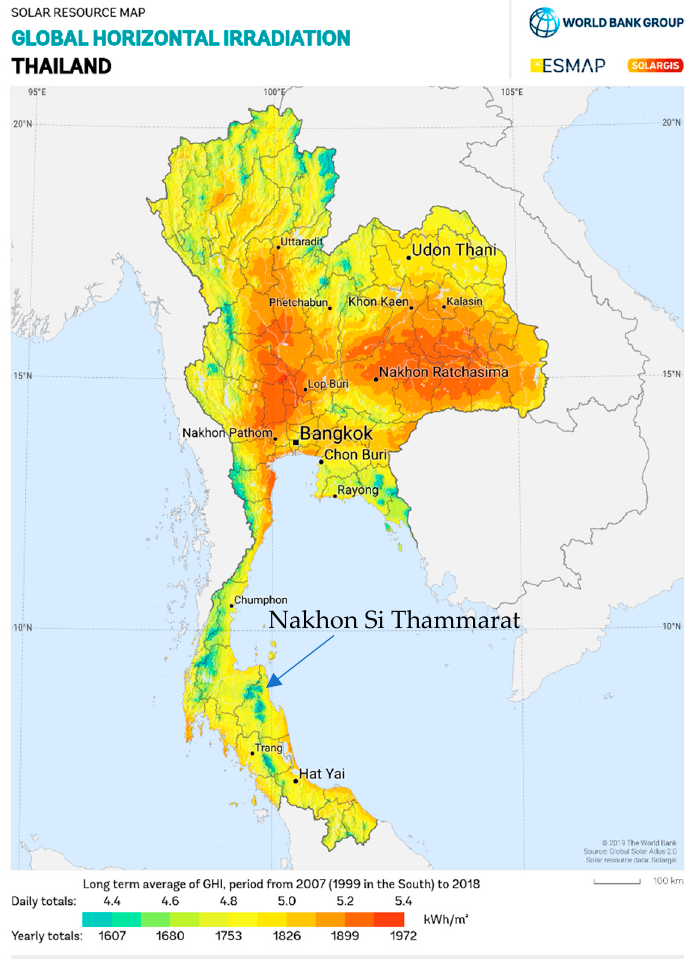
Figure 4. Thailand long-term average of global horizontal irradiation (kWh ⋅ m − 2 ·year − 1 ) [18] .